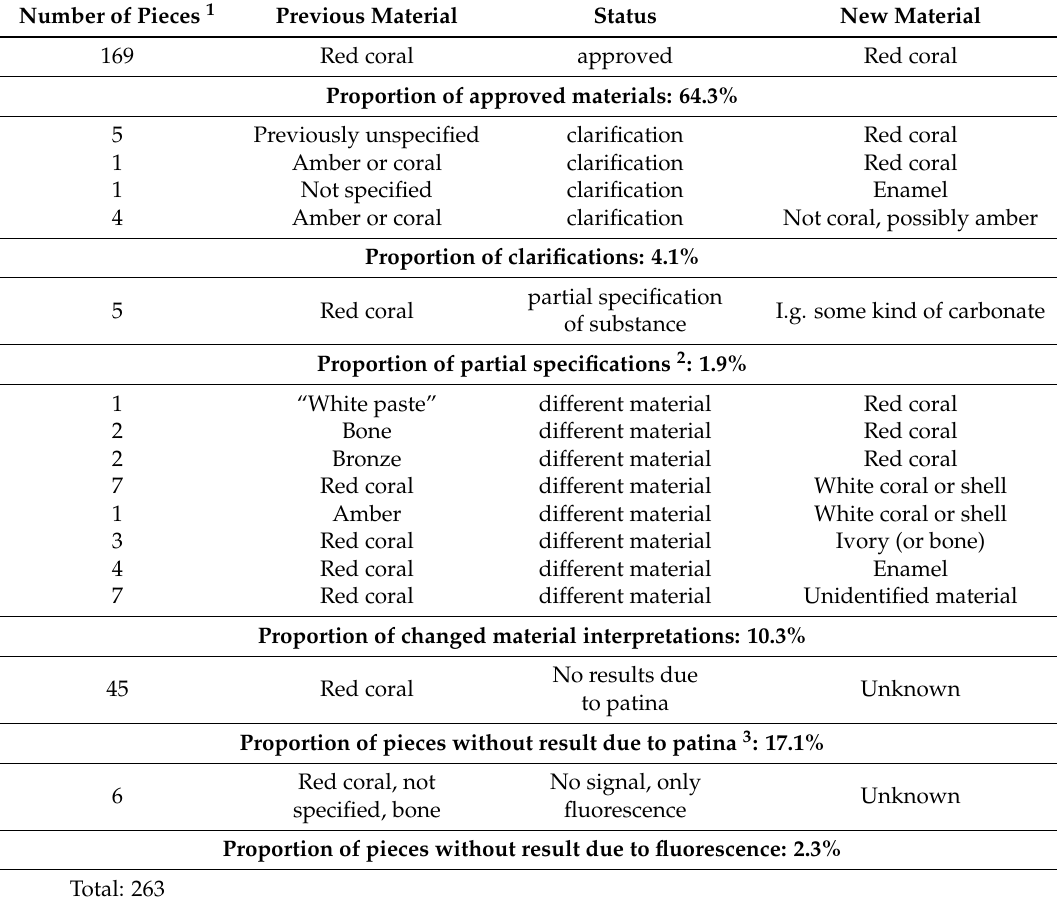
Table 2. Non-representative list of investigated decorative elements showing the previously-supposed material, the specific result of our examination and, finally, the interpretation of the data in terms of the most probable original material. The data consist of Raman spectroscopic and optical